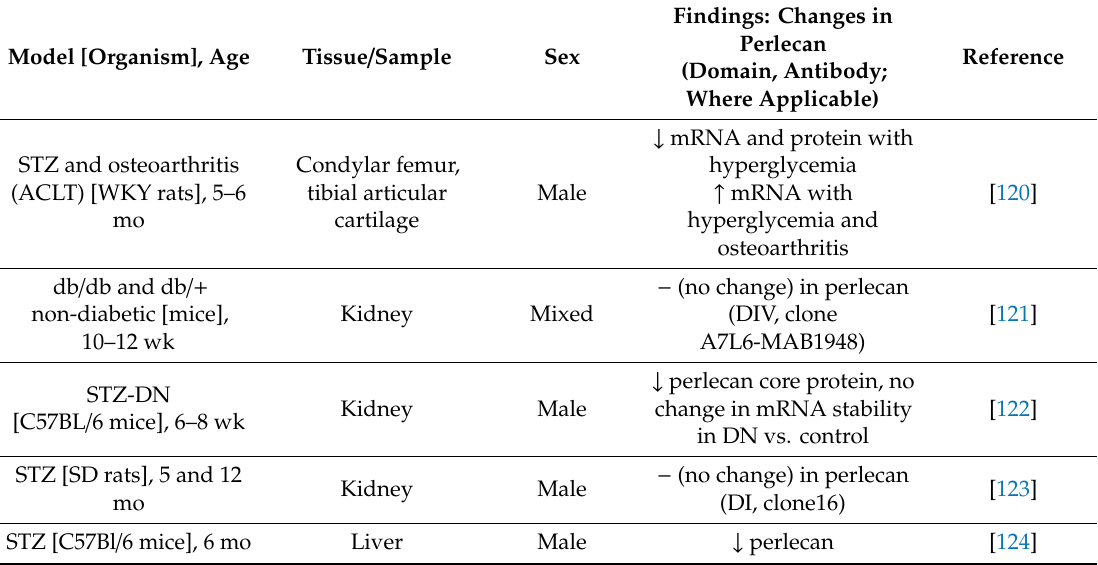
Table 1. Metabolic Changes and